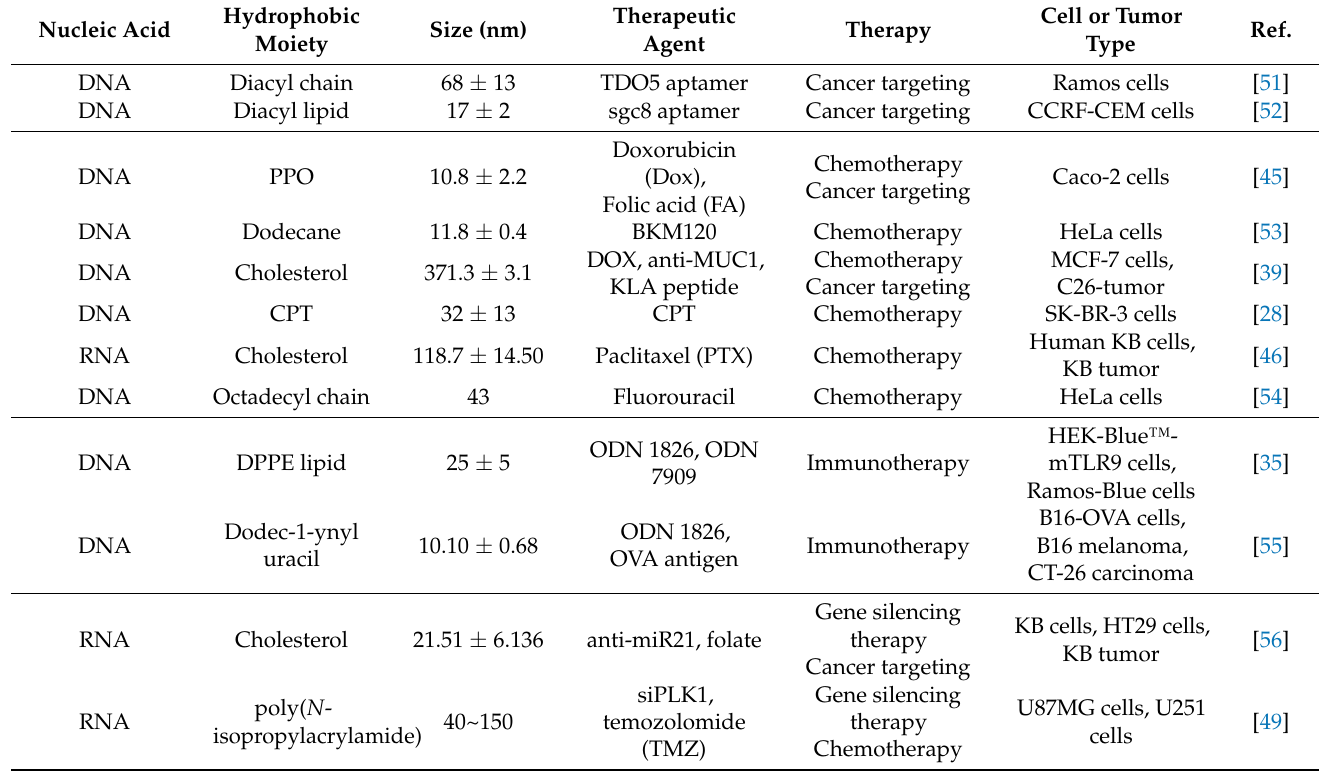
Table 1. Examples of various nucleic acid-based micelles for cancer